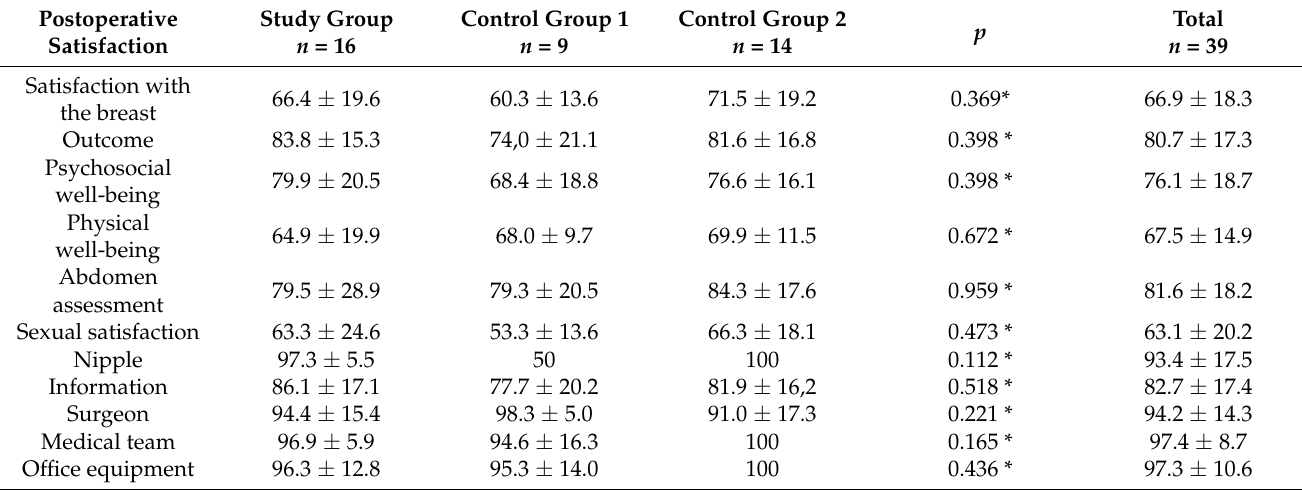
Table 7. Postoperative Breast Q